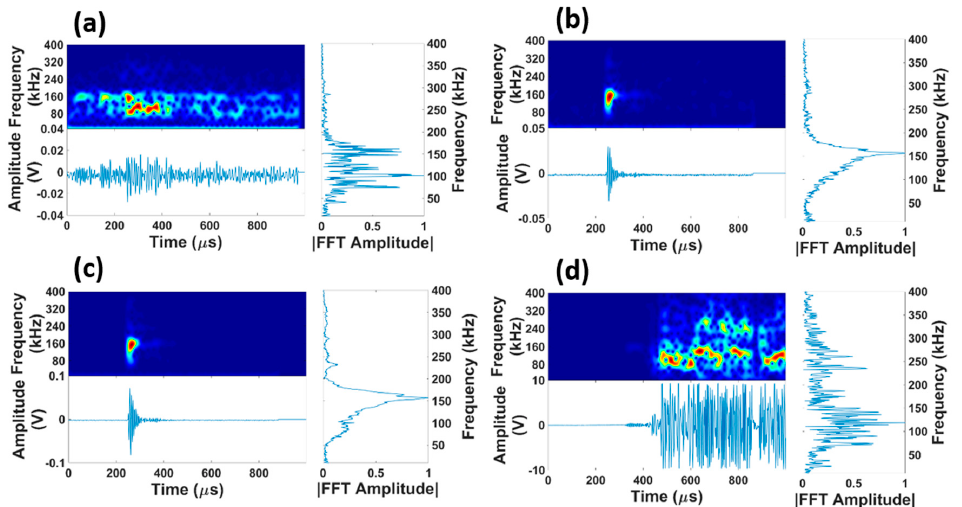
Figure 2. Sample AE activity observed during Test 8 at four different load points. ( a ) Zero load, ( b ) during the first load step, ( c ) during the second load step, and ( d ) at final failure.